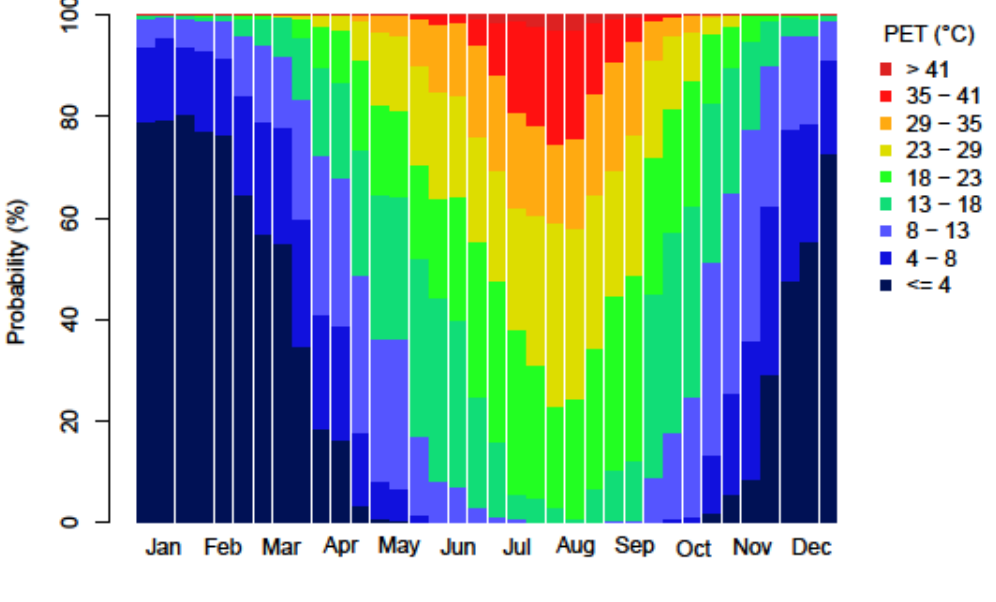
Figure 3. Frequency diagram (decades) showing the average occurrence of Physiologically Equivalent Temperature (PET) classes for Tokyo during the period August 1966 to June 2018 (3 h resolution). The reference height for the results is 1.1 m. The sensation classes are defined in Table 2.